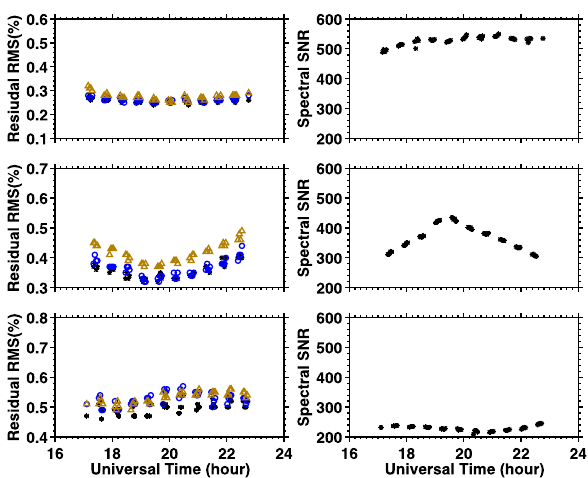
Fig. 5. Root mean square (RMS) of spectral fitting residuals (left panels) and spectral SNR (right panels) as a function of time for the measurements of CO 2 and O 2 column densities in Spectralon ® viewing (top panels); over Santa Anita Park (middle panels); over west Pasadena (bottom panels). Three spectral bands centered at 6220cm − 1 (black stars, noted as MW6220 thereafter), 6339cm − 1 (blue circles, noted as MW6339 thereafter) and 7885cm − 1 (gold triangles, noted as MW7885 thereafter) are presented. The spectral SNRs were nearly identical over the three spectral bands in a mea- sured spectrum, but they vary among spectra. The measurements were performed on 3 January 2013. The spectral fitting residuals were normalized by the spectral continuum levels prior to the com- putation of RMS values. The spectral fitting residuals were dom- inated by the photon shot noise. The chi-squared tests of spectral fitting residuals yielded values less than 1.3.